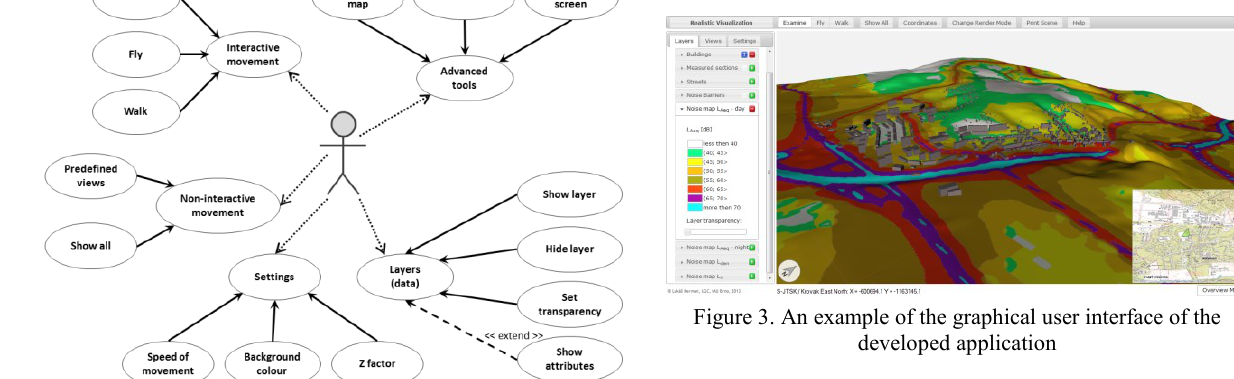
Figure 1. Use case diagram of the developed application